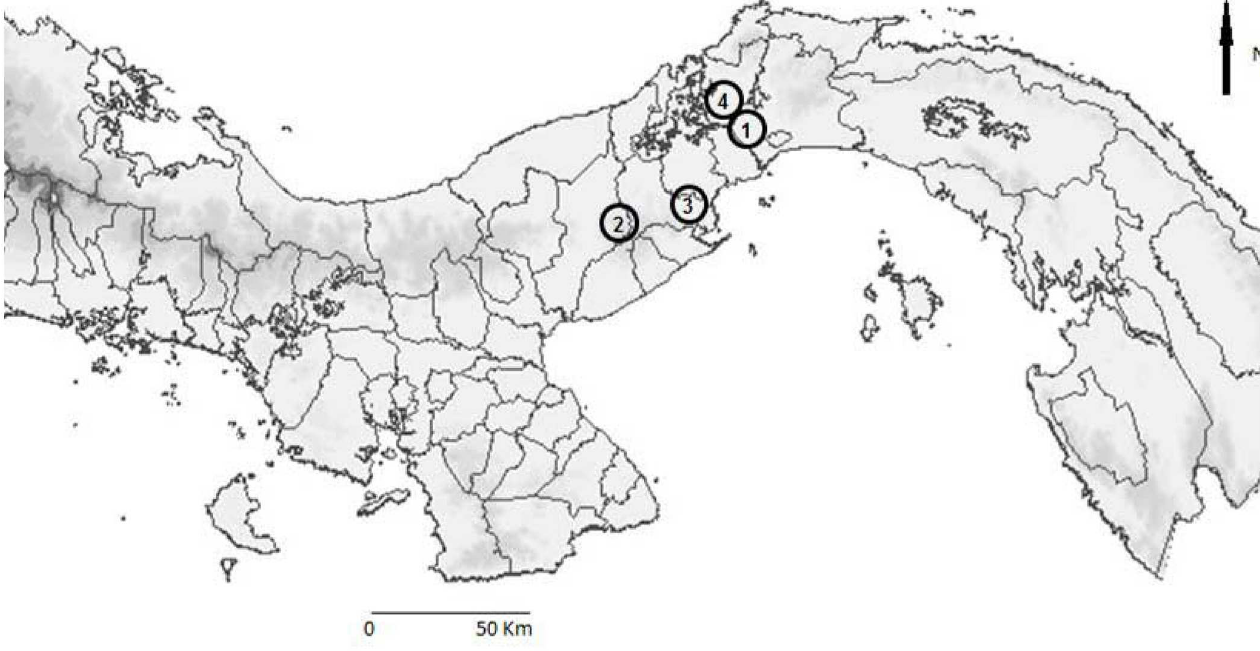
Fig 1. Map of Panama showing the geographical sites: Summit Municipal Park (1), El Nı´spero (2), Capira (3), Gamboa